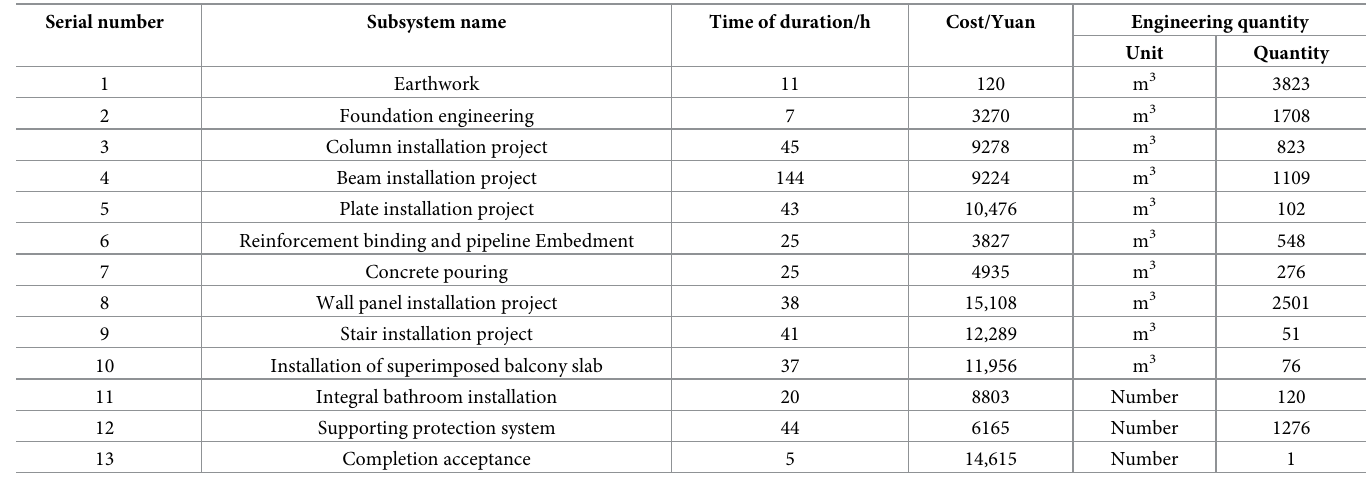
Table 3. Basic information of each